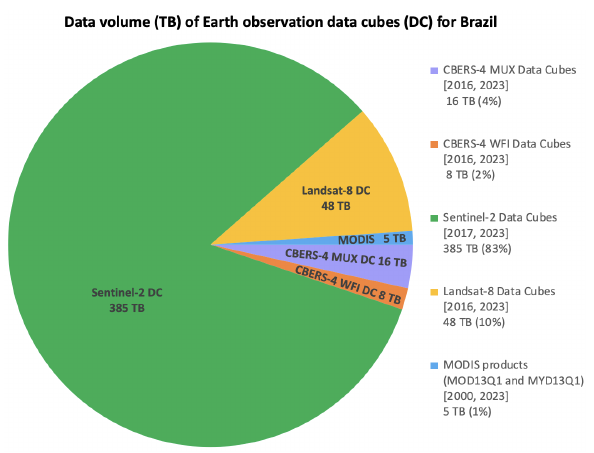
Figure 4. Data volume (TB) of Earth observation data cubes for